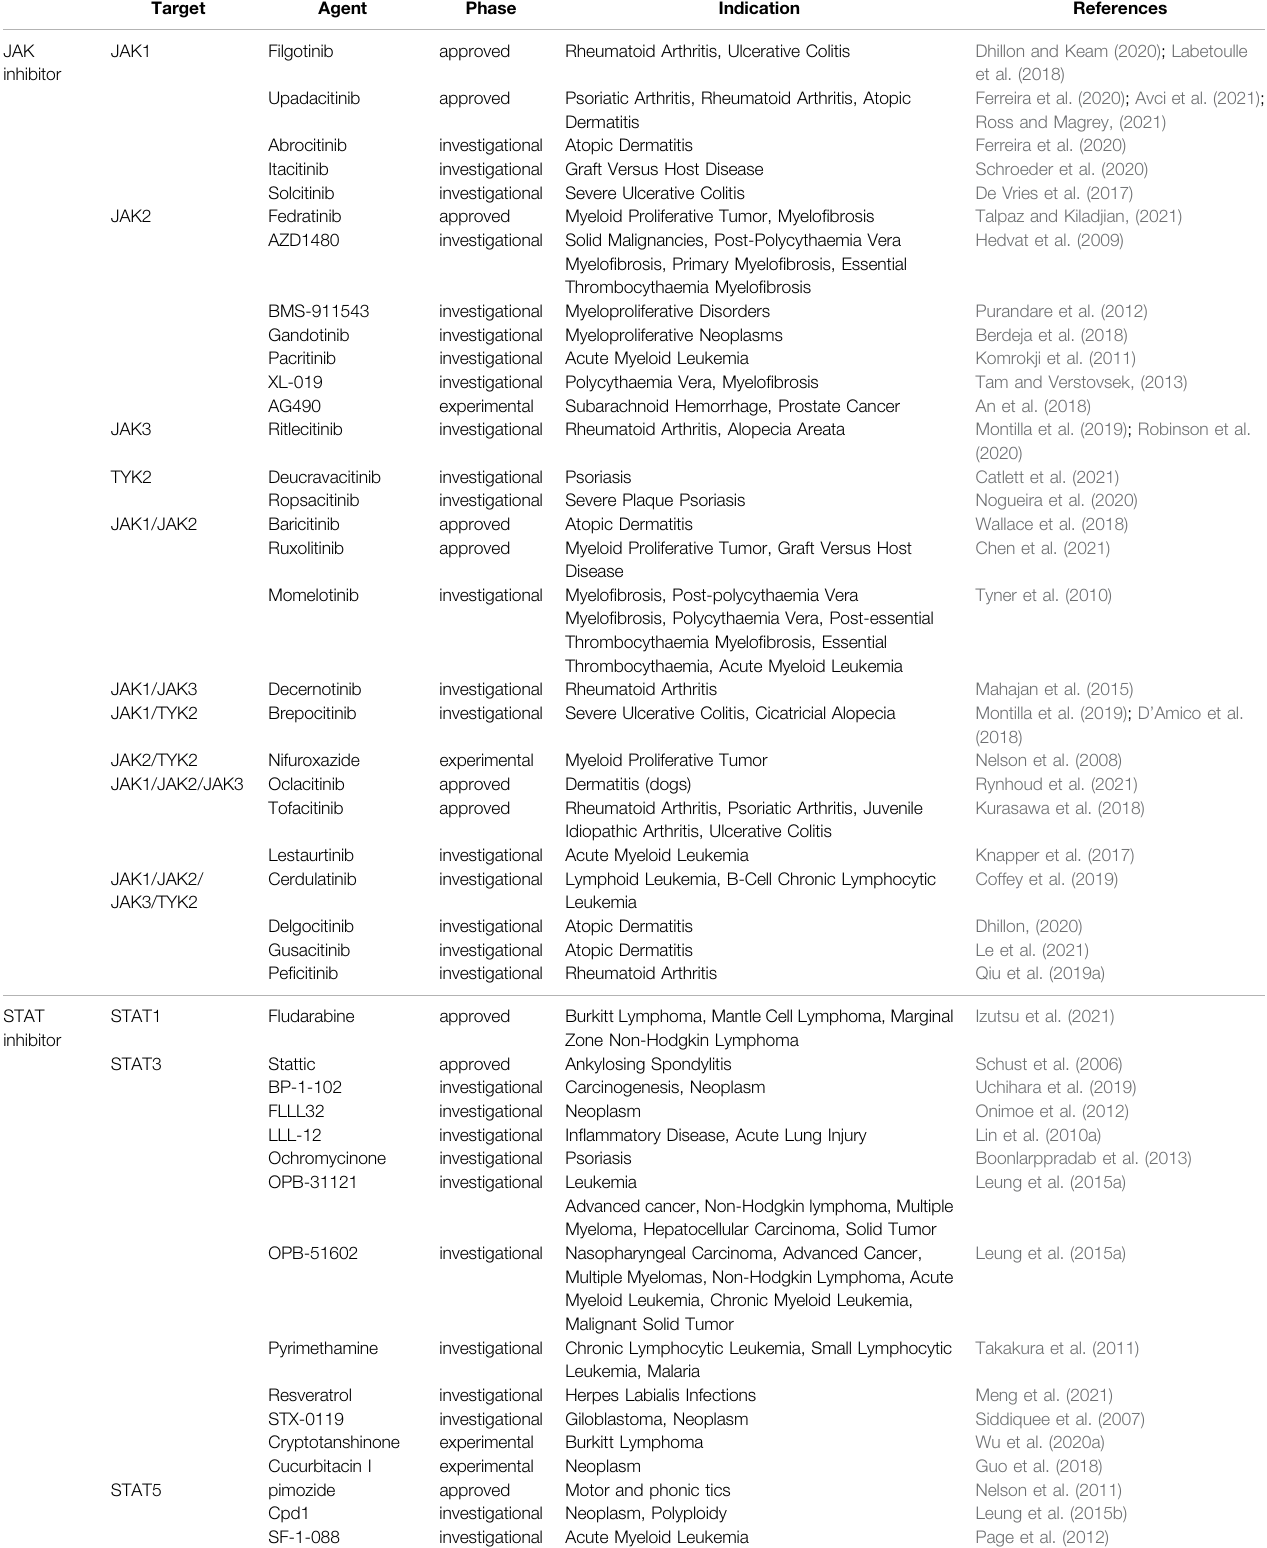
TABLE 1 | Targets in and inhibitors targeting the JAK-STAT